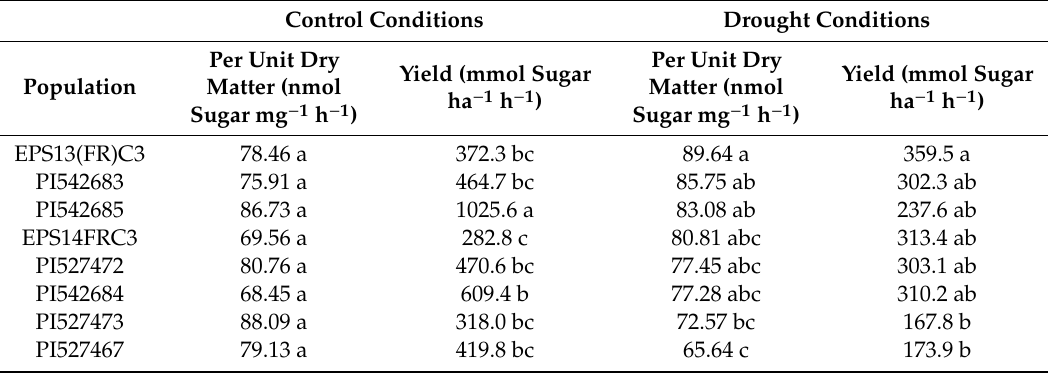
Table 2. Saccharification 1 in six Algerian maize populations and two Spanish checks under drought and control